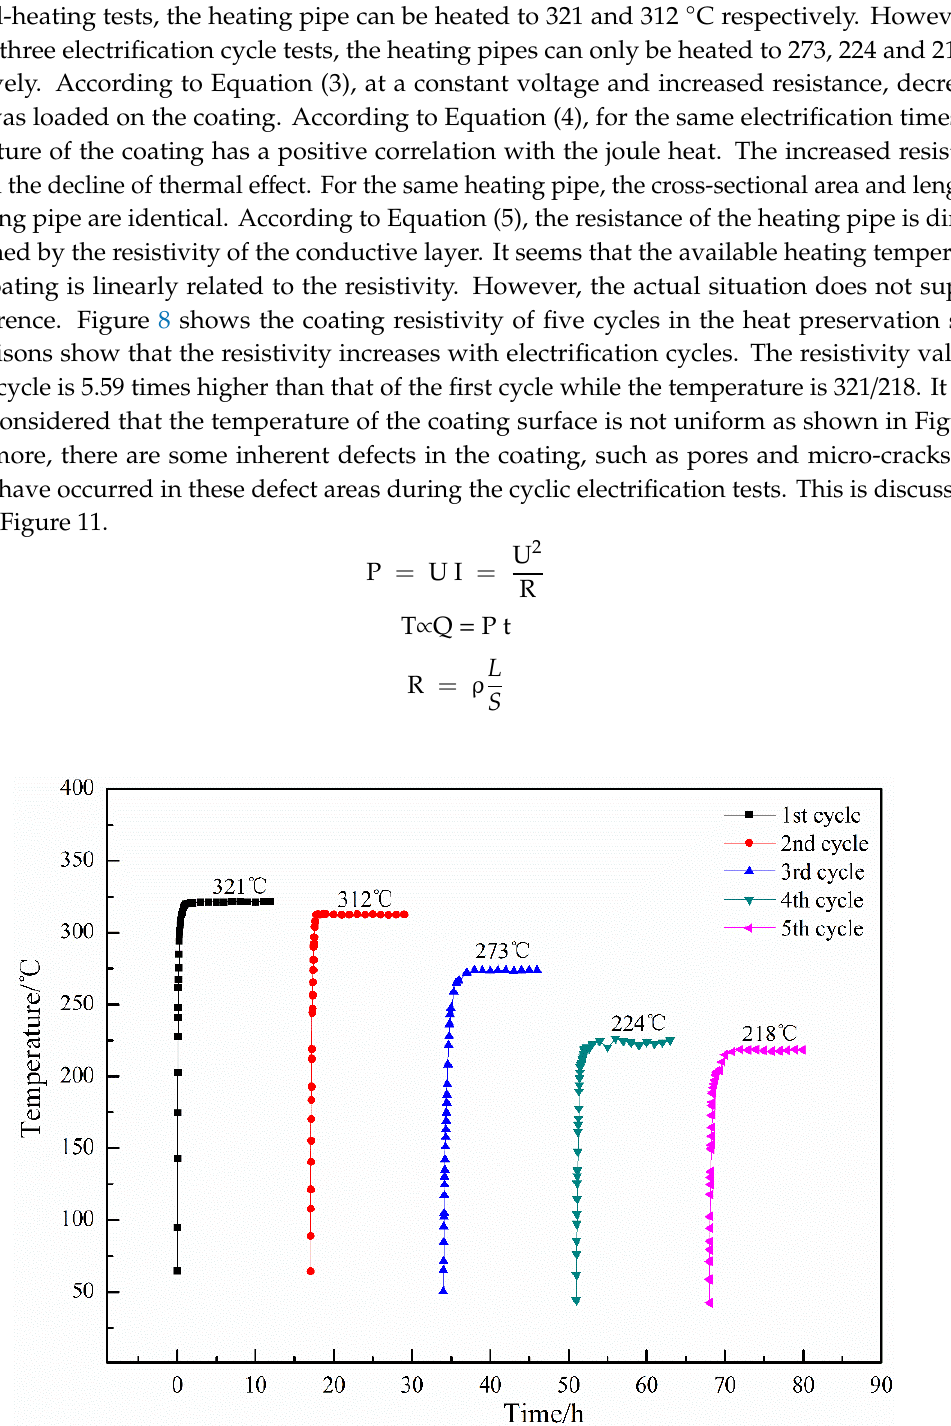
Figure 8. The coating resistivity of five electricity tests in the heat preservation stage.